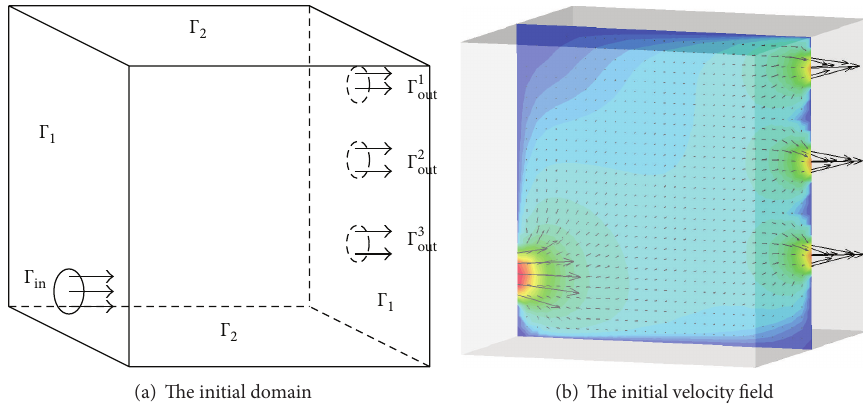
Figure 5: The initial domain and velocity